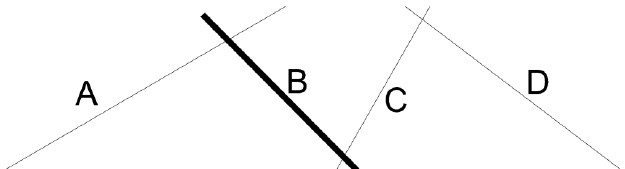
Figure 2. Space syntax indices calculation for the line B (marked line) in an example with 4 lines (streets). The depth between the lines B and A is 1 (because an observer performs only one change of perspective to go from B to A), between lines B and C is 1 and between lines B and D is 2. The total depth for the line B is D t = 1 + 1 + 2 = 4 and the total number of lines of the system is k = 4, so the integration index value is I = 3 / 4. All the possible paths between the four lines are A–B, A–B–C, A–B–C–D, B–C, B–C–D and C–D ( N t = 6). The paths containing the line B are 5 ( N l = 5). The choice index is Ch = (5-3)/(6-3) = 2/3.